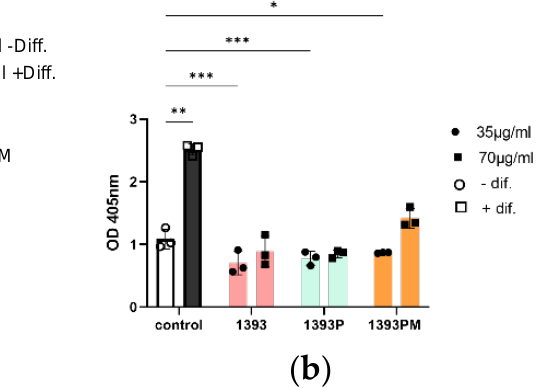
number of replicates per condition are shown on the graph; ANOVA 2-way test corrected using Tukey test for multiple comparisons; * p < 0.05, ** p < 0.01, *** p <